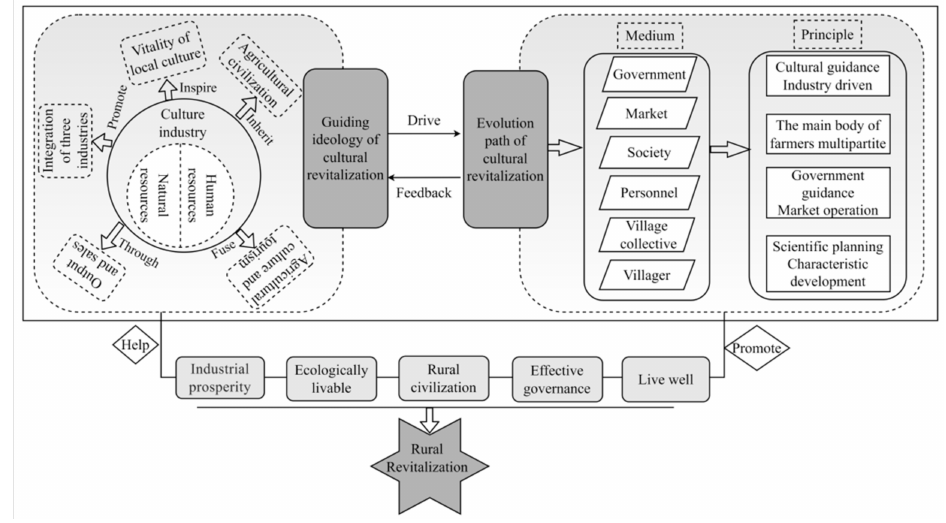
Figure 10. Schematic diagram showing the framework of rural revitalization from the perspective of cultural